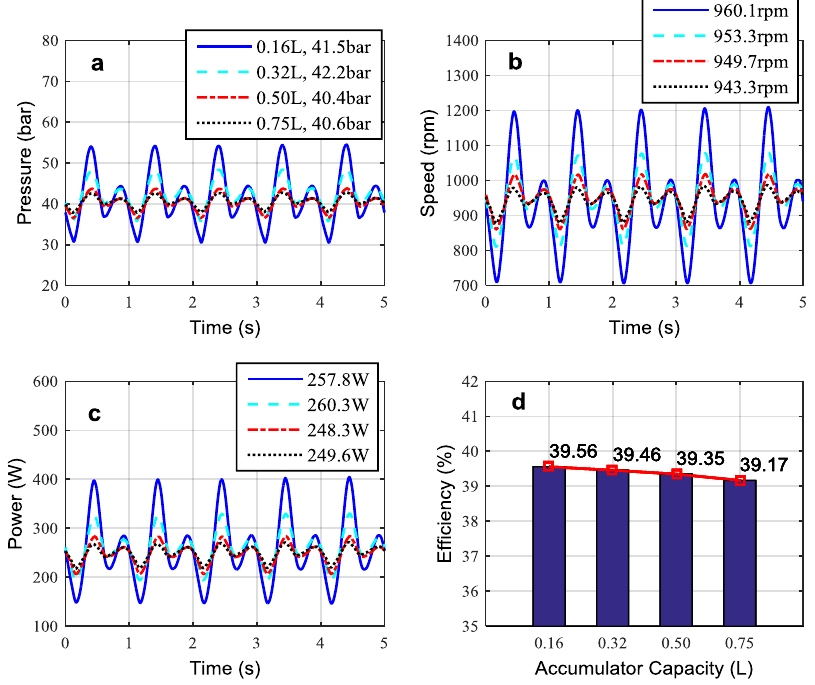
Figure 17. ( a ) Measured motor pressure; ( b ) measured shaft speed; ( c ) measured regenerative power; ( d ) measured power regeneration efficiency, at 0.16 L, 0.32 L, 0.50 L and 0.75 L accumulator capacity.